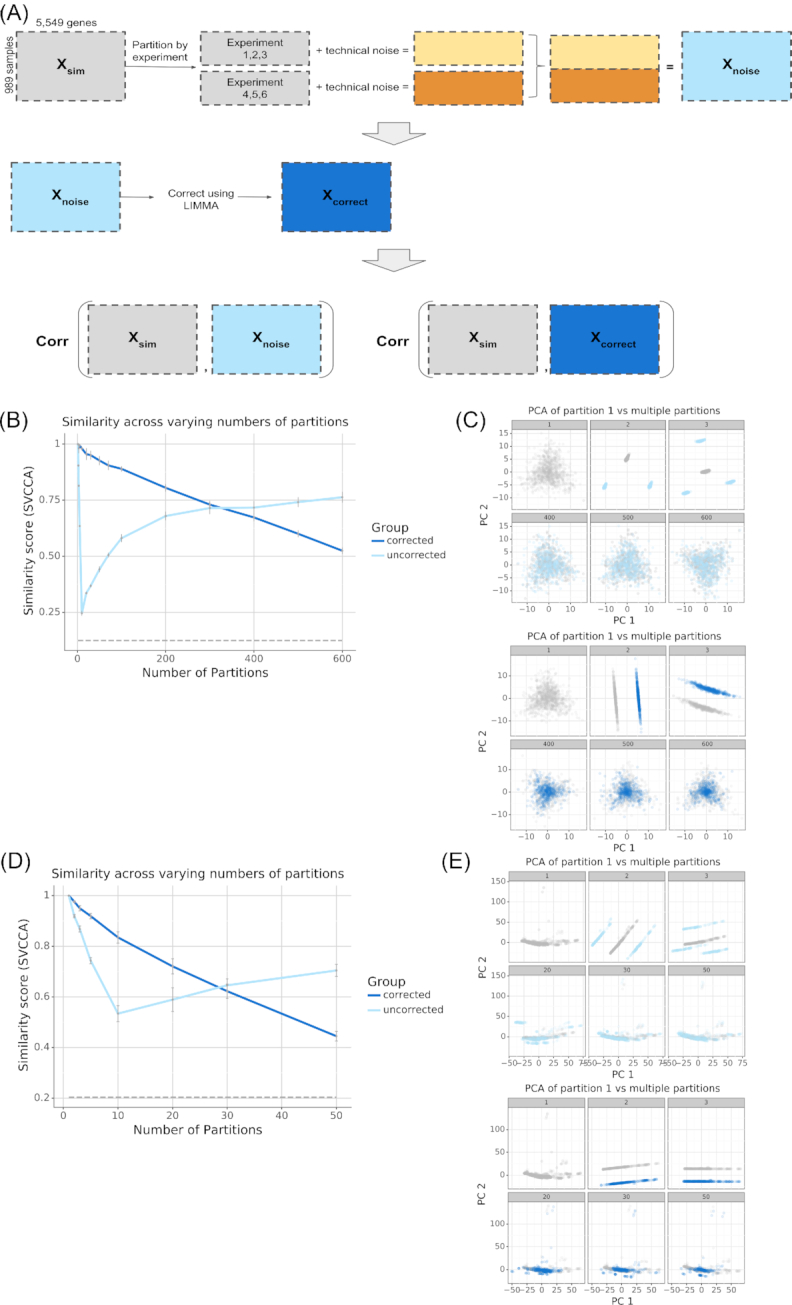
Results of simulating compendia composed of gene expression experiments. (A) Workflow describing how experiment-specific noise was added to the simulated compendia and how the noisy simulated compendia were evaluated for similarity compared to the unpartitioned simulated compendia. (B, D) SVCCA curve measuring the similarity between a compendium without noise vs a compendium with noise (light blue), and compendium with noise corrected for (dark blue). As a negative control, we used the similarity between the gene expression pattern of the compendium without noise with a permuted compendium, where the genes were shuffled (dashed grey line) to destroy any meaningful structure in the data. (C, E) Subsampled gene expression data (500 samples per compendium) projected onto the first 2 principal components showing the overlap in structure between the compendium without noise (gray) vs the compendium with noise (light blue), and compendium with noise corrected for (dark blue). PCA: principal component analysis.